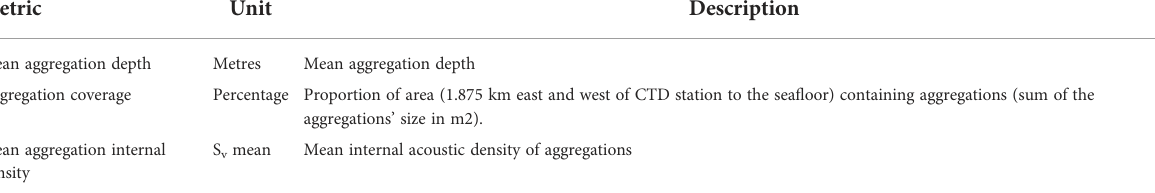
TABLE 2 Summary of metrics calculated from the acoustic aggregation data measured along transects.